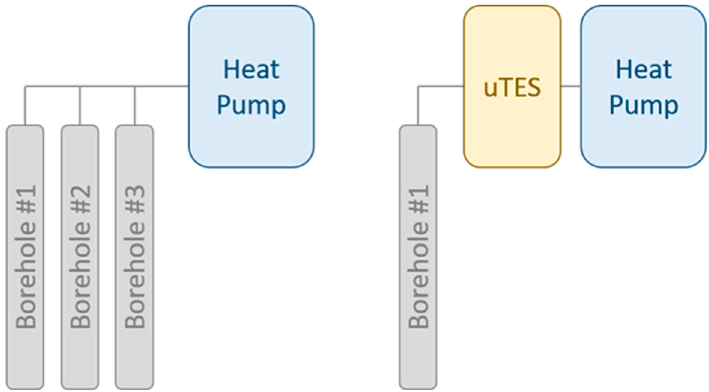
Figure 1. Layouts of the baseline setup ( left ) and the upgraded setup using an upstream thermal storage (uTES) ( right ).